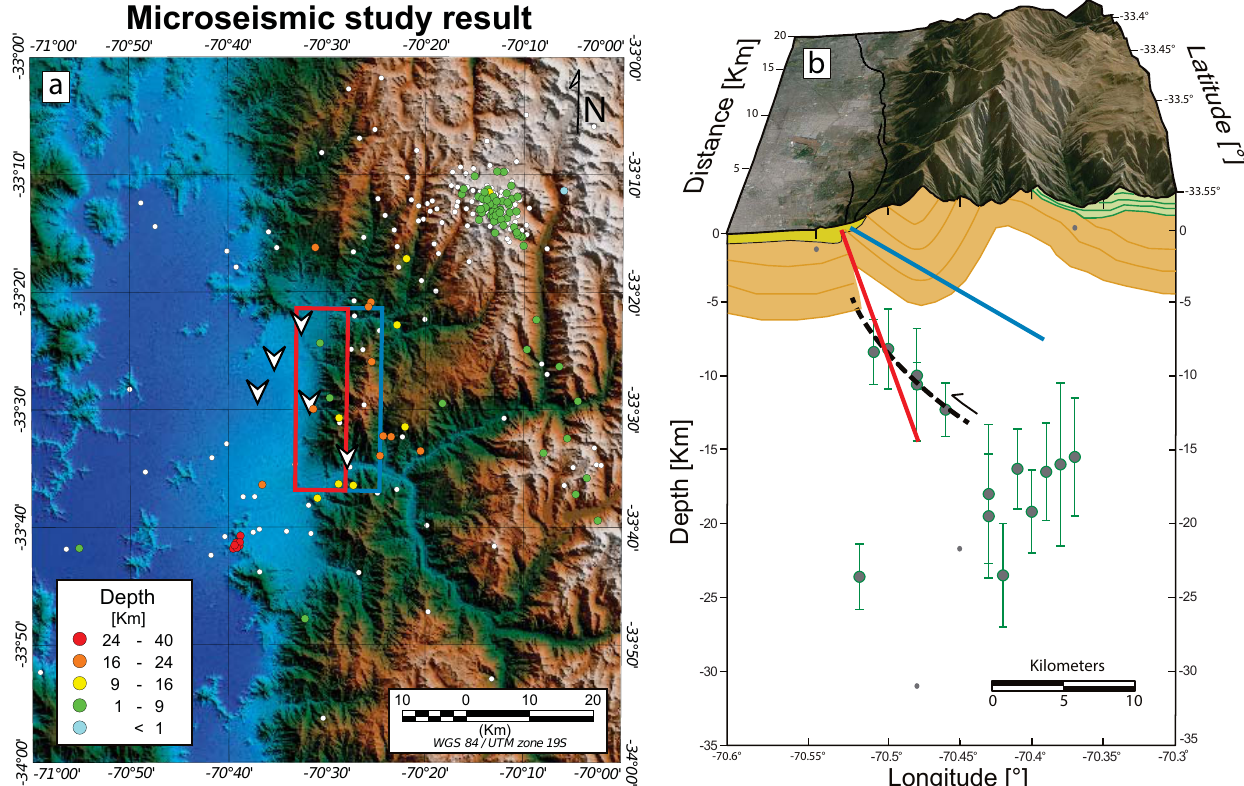
Figure 4. Microseismic study results. In the left panel is the map with epicenters of the recorded events. The color represents depth of the hypocenter. In white are the events with localization errors larger than 8km. White inverted triangles are the seismic stations. The red rectangle represents the 70 ◦ projection plane on the surface, and the blue rectangle represents the corresponding 30 ◦ projected plane. The right panel shows the seismic profile with well-recorded events (depth error bands in green). The poorly located events are indicated with little grey points without band error. The red and blue lines represent the planes of 70 and 30 ◦ , respectively. The dashed black line represents the interpretation of the SRF. The geological projection is based on the first kilometers of the section from Armijo et al.